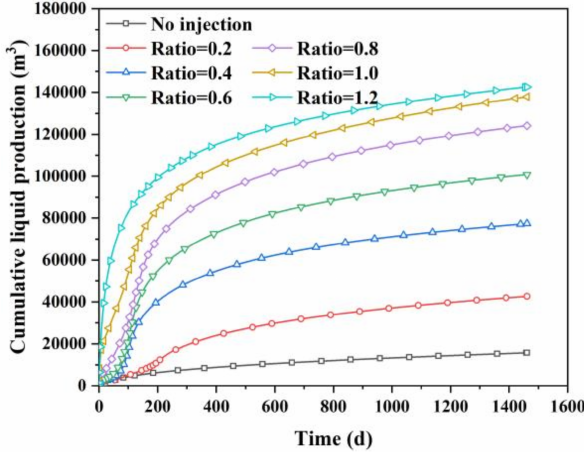
Figure 15. Cumulative liquid production of parent well.